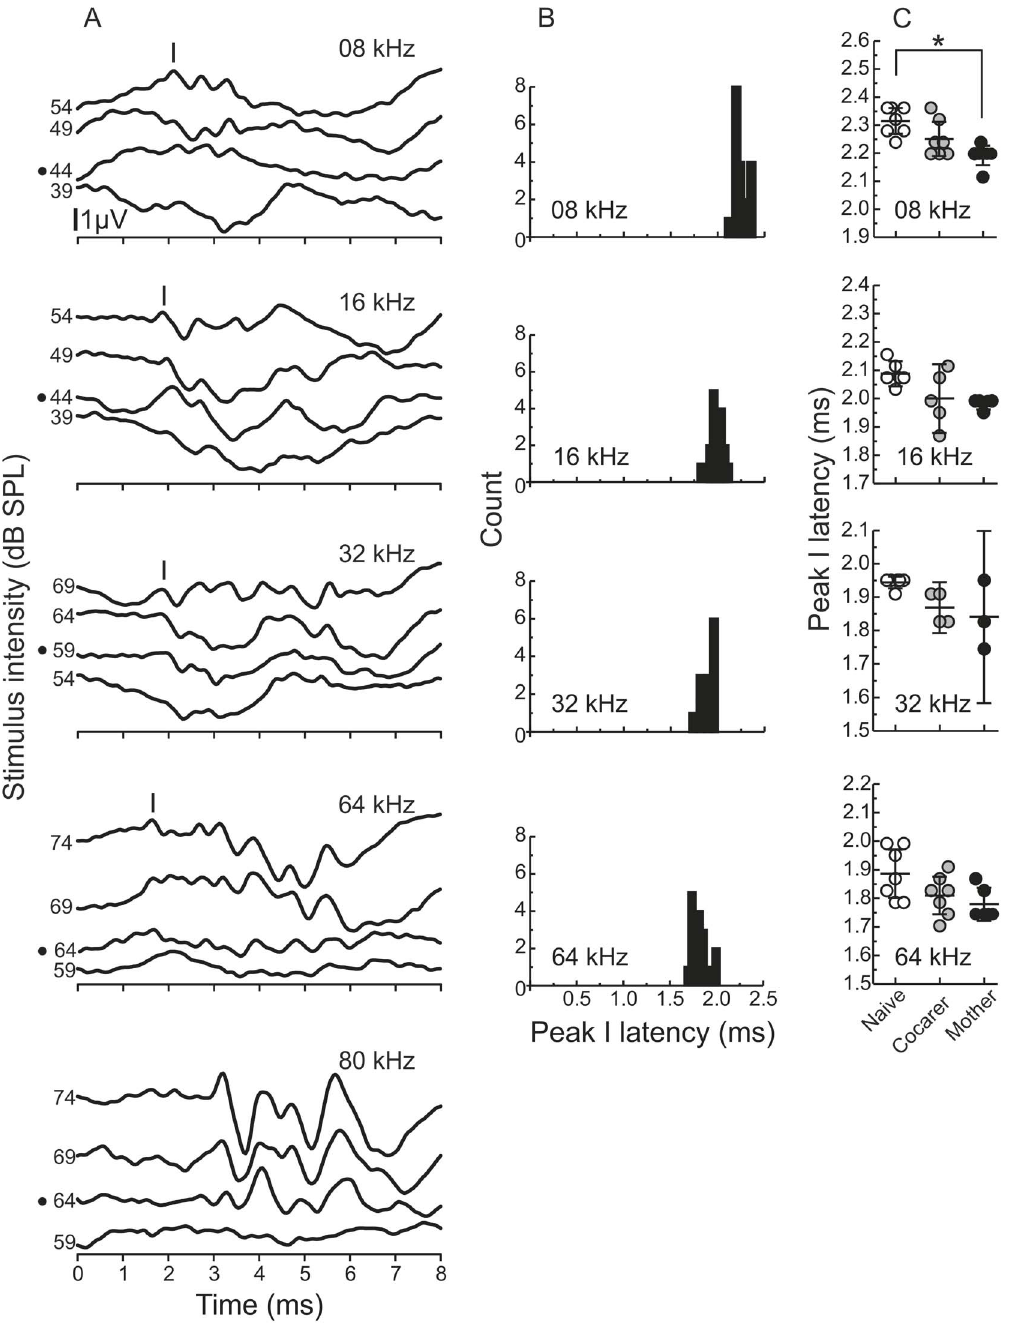
Figure 4. Maternal experience significantly influences tone pip-evoked ABR peak latencies. A) Representative averaged traces from individual animals in response to tone pips at different frequencies (500 presentations per stimulus intensity). The black dot to the left of the y-axis denotes the threshold stimulus intensity. Peak I is labelled in each auditory brainstem response with the exception of 80 kHz as we were unable to identify a Peak I latency at this frequency. B) Distributions of latencies for all animals combined. Latencies measured 10 dB above each animal’s threshold. Bin width=0.02 ms C) Effects of pup-care experience on peak I latencies. Dots show individual latencies for each animal with the middle horizontal bar representing the mean, and error bars denoting 95% confidence intervals. Asterisk indicates significance at the p , 0.01 for the indicated post-hoc comparison.